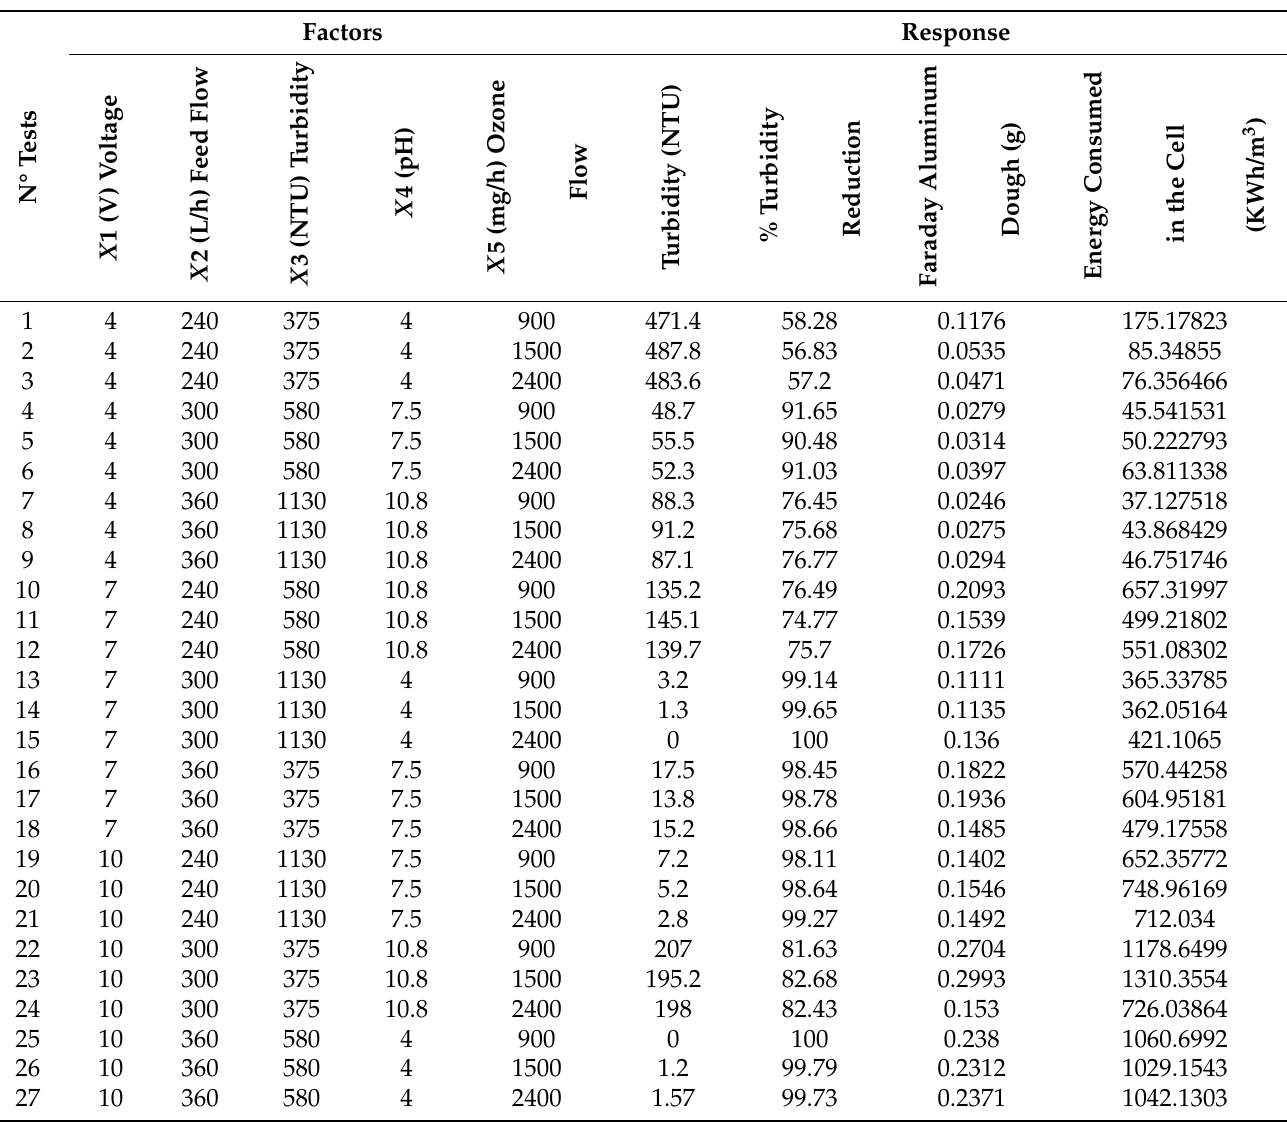
Table 3. Presents the results of the 27 experiments carried out using the Taguchi methodology of five factors at three levels under